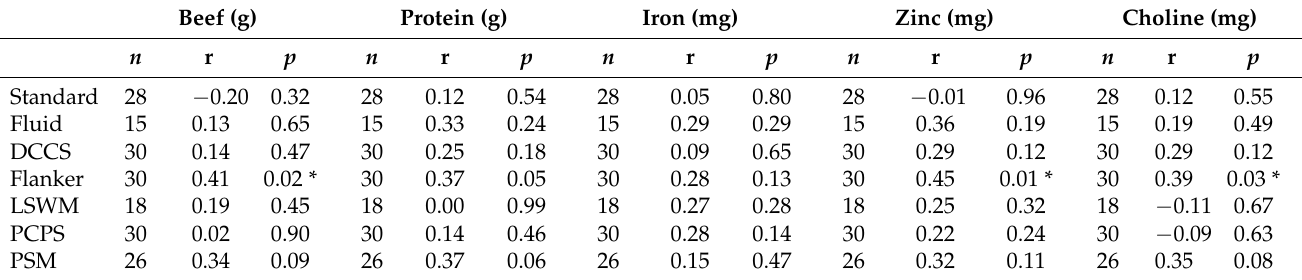
Table 5. Relationship between dietary intake at 6–12 months and cognitive scores at 1–5 years of